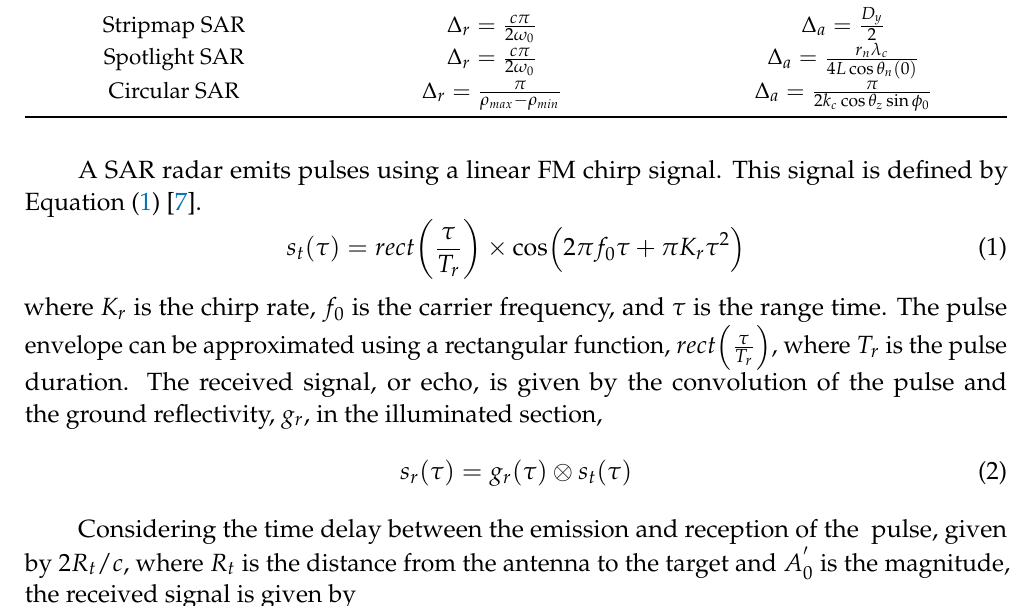
Table 2. Range and azimuth resolution of Stripmap, Spotlight, and Circular SAR [1]. Stripmap SAR ∆ r = c π Spotlight SAR ∆ r = c π Circular SAR ∆ r = π